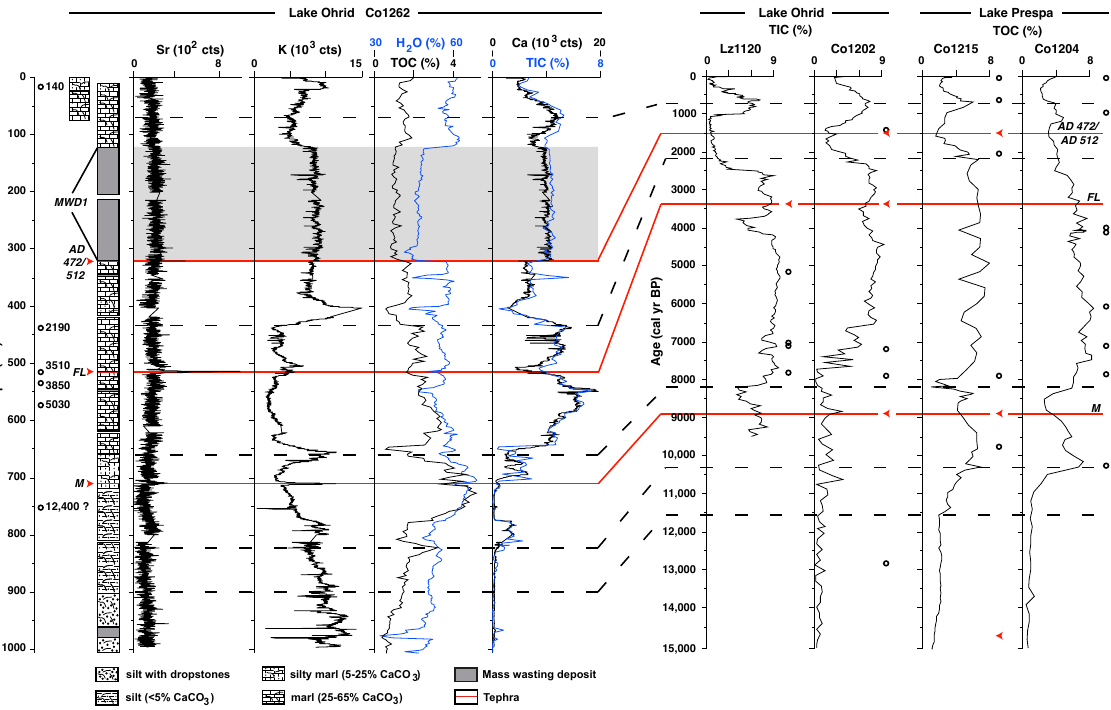
Fig. 4. Lithology, water content, and geochemical composition of core Co1262 from Lake Ohrid. Note that the entire sediment succession appears massive due to bioturbation. The gaps in XRF scanning data (Sr, K, and Ca counts) are due to non-overlapping cores. These gaps are smaller in water content, TIC, and TOC, as core catcher samples are included. The cross correlation with cores Lz1120 and Co1202 from Lake Ohrid and cores Co1215 and Co1204 from Lake Prespa (black dashed lines) can be used for an age estimation of core Co1262. Red arrows and lines indicate tephras and cryptotephras (AD472/512, FL eruption, and M=Mercato). Black circles indicate radiocarbon dated horizons in cores from lakes Ohrid and Prespa (ages in core Co1262 are calibrated ages from Table